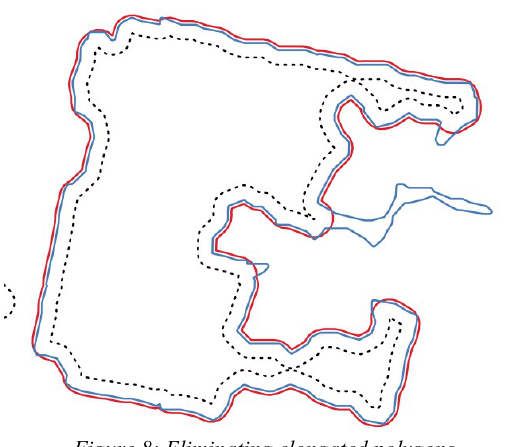
Figure 8: Eliminating elongated polygons As a result, parts of polygons with at least one side shorter than the selected buff size are deleted from the final outcome.